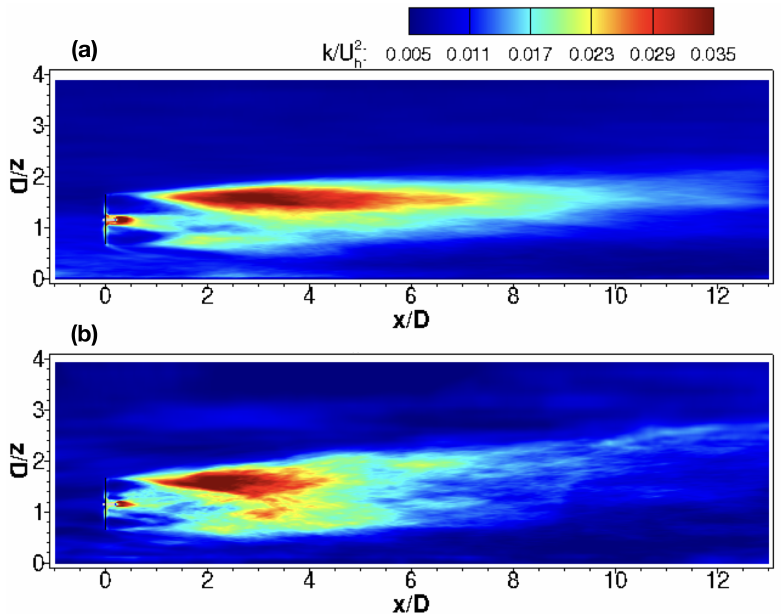
Figure 7. Turbulence kinetic energy (TKE) on the x-z plane passing through the rotor center for ( a ) T80 and ( b ) T27,